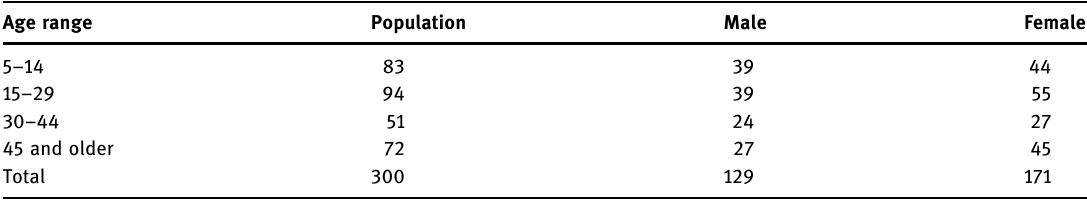
Table 4: Participants characteristics by age and gender ( n )